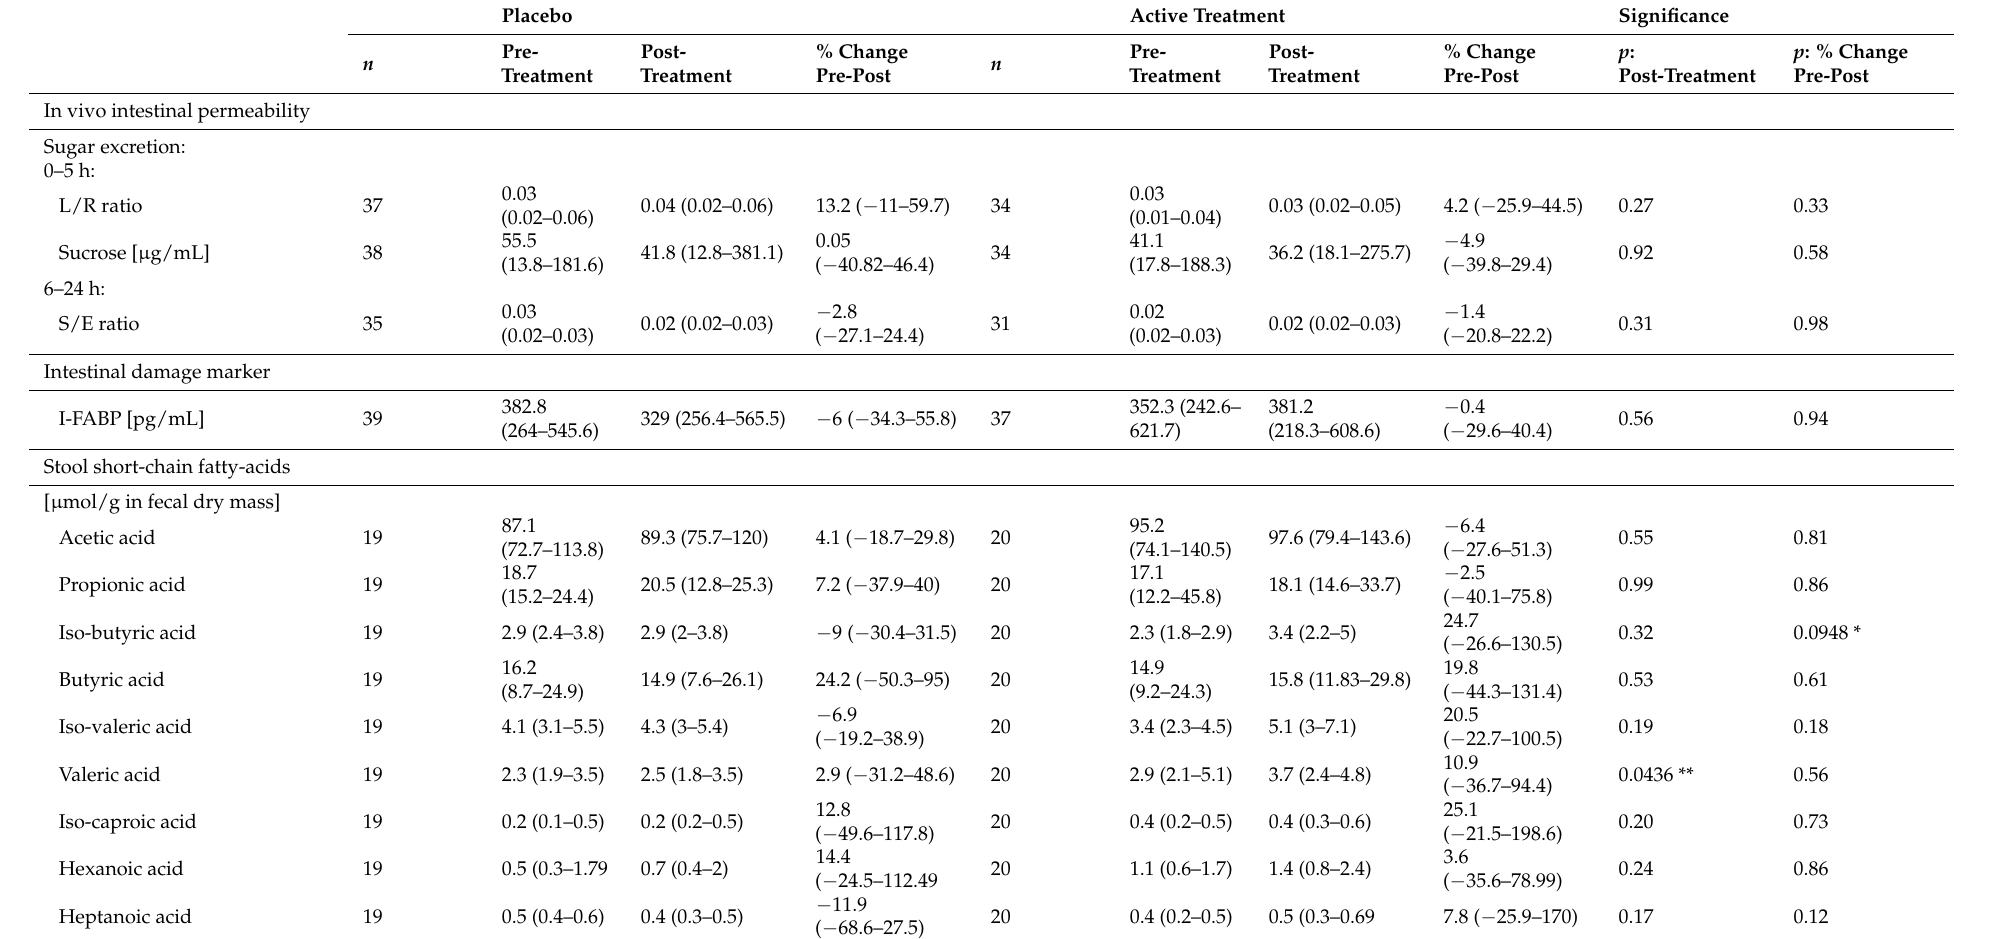
Table 3. Gut-health related